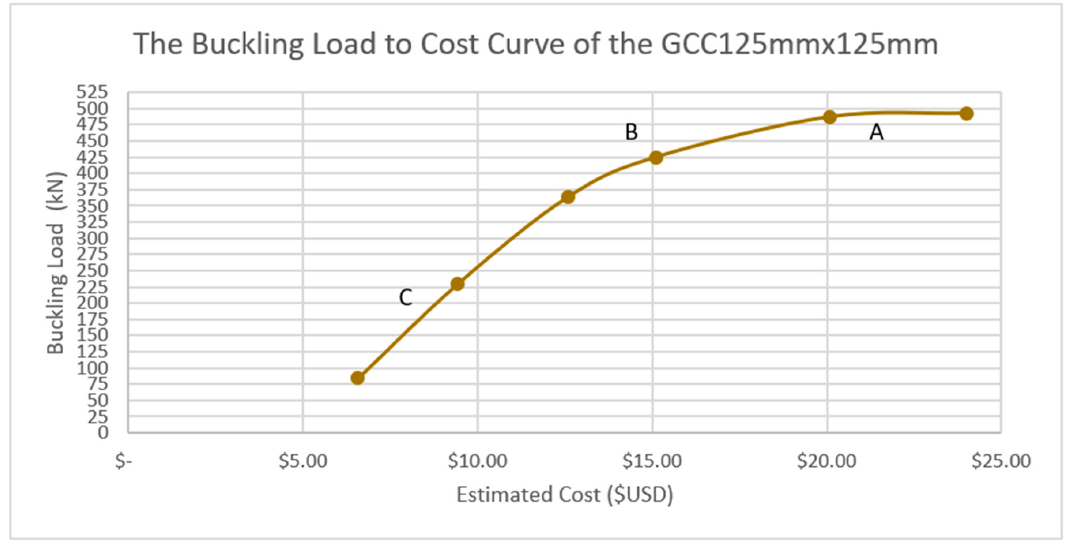
Figure 15. The buckling buckling load vs. cost graph for the GRCC 125 × 125 × 3. The glass is varied to produce the cost curve. This figure highlights the regions A, B, and C, each having specific attributes.